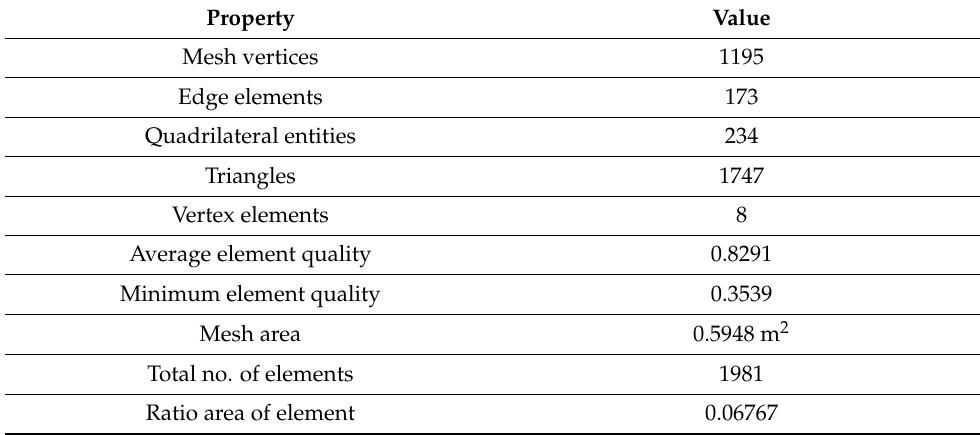
Figure 24. The validation figures with [17] and our obtained results. Table 2. A description of the mesh